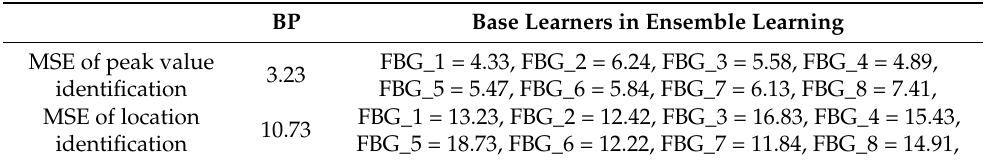
Table 2. Comparison of the MSE between BP and the base learners in ensemble learning.